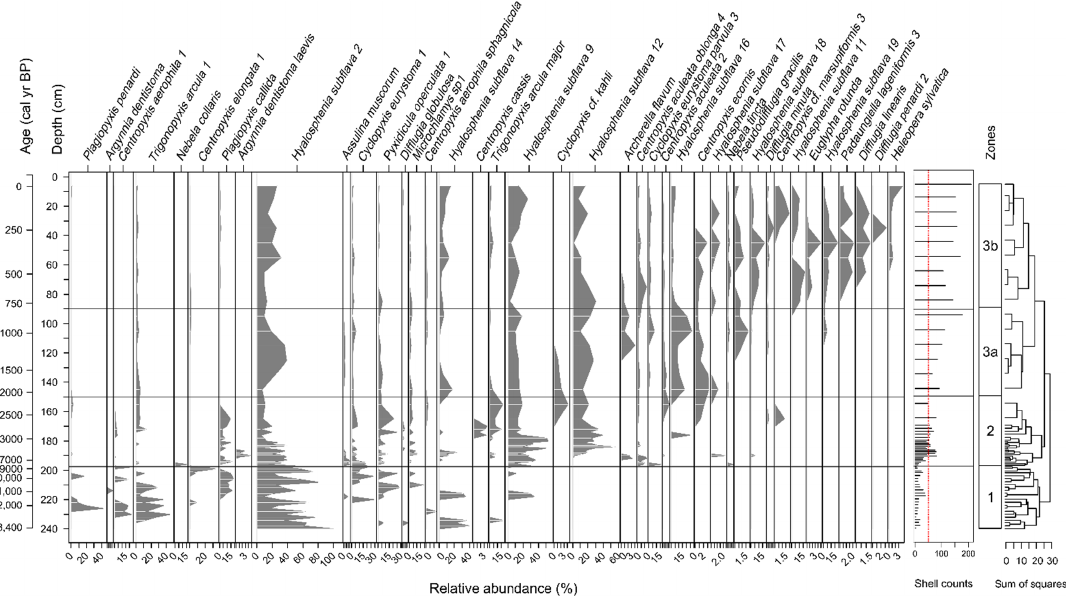
Figure 2. Testate amoeba morphospecies (the number after the morphospecies name stands for the morph type) diagram from the Sungai Buluh peatland (Central Sumatra, Indonesia). The zonation is based on a constrained incremental sum of squares. The taxa are ordered by the weighted average of the depth/age axis. For clarity, only taxa observed in five or more samples or with a relative abundance of ≥ 3% per sample are shown.